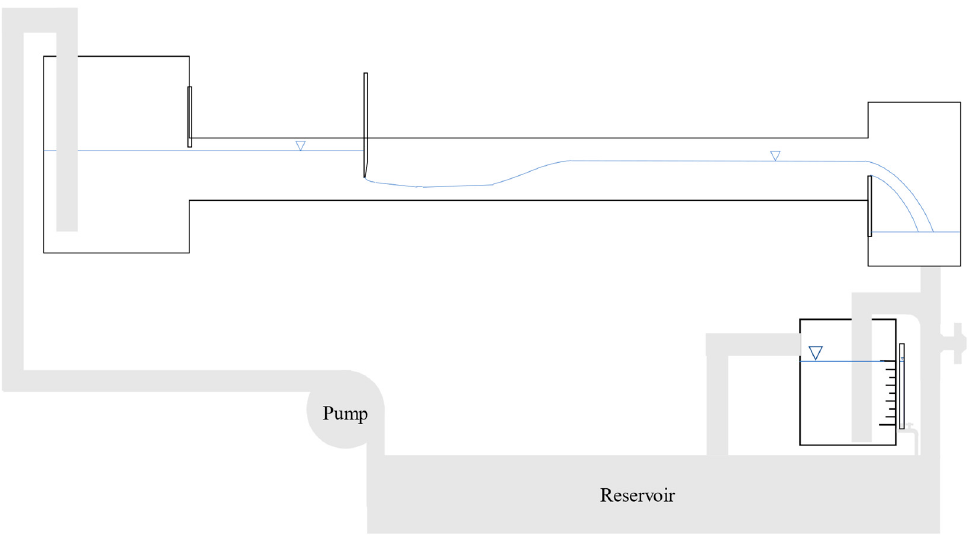
Figure 4. Schematic of the lab experiment configuration (not to scale).